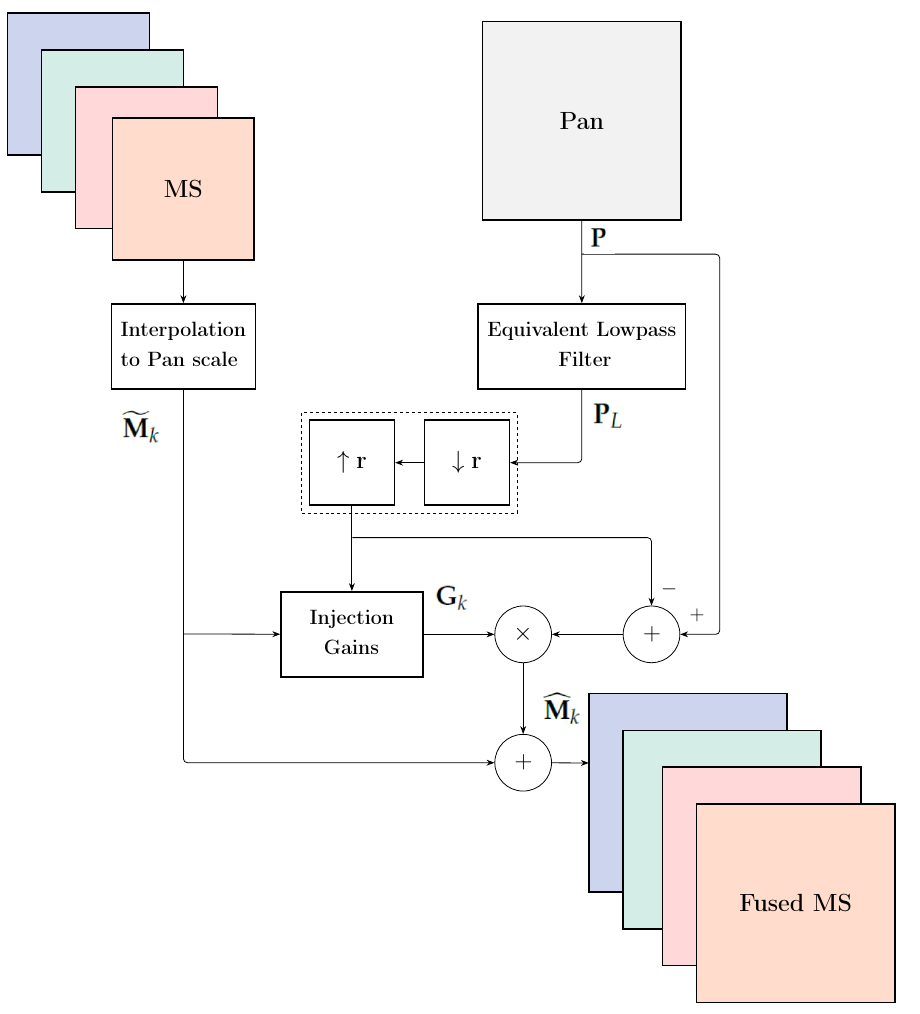
Figure 3. Flowchart of a typical fusion method belonging to the MRA class. r denotes MS-to-Pan r decimation by r and r linear interpolation by r . The dotted block is optional and pixel size ratio, ↓ ↑ switches the à trous analysis into the pyramid analysis